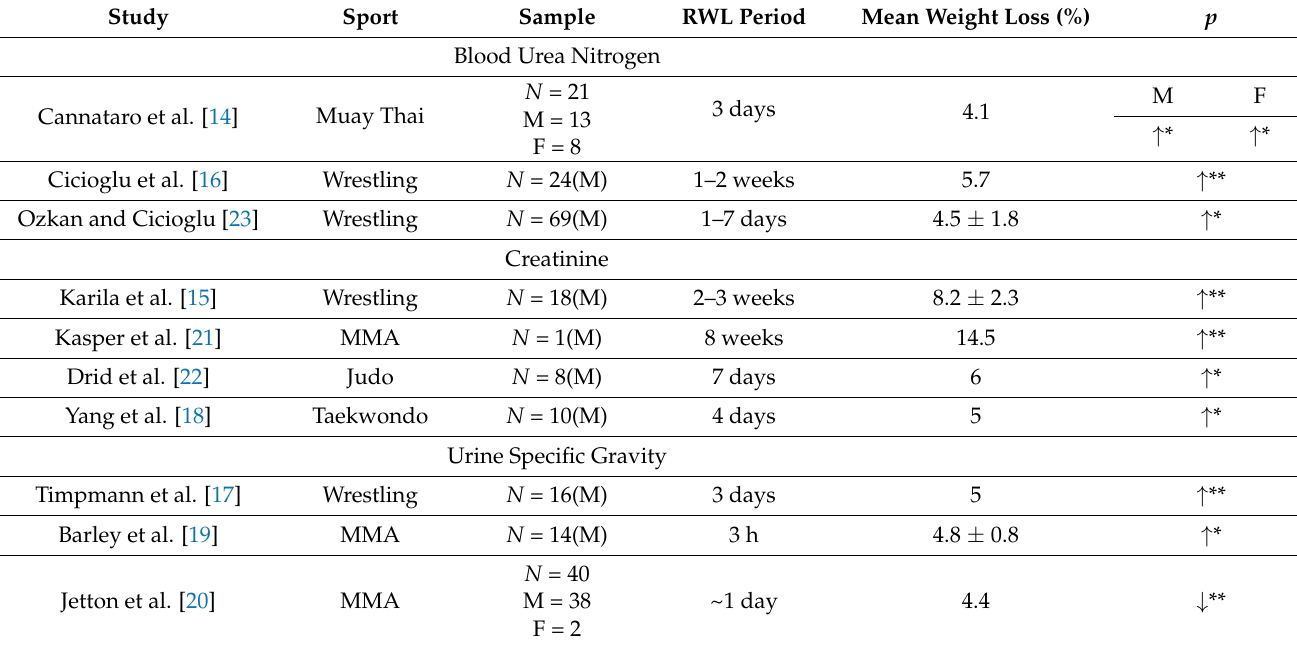
Table 1. Effects of rapid weight loss on kidney function in combat sport